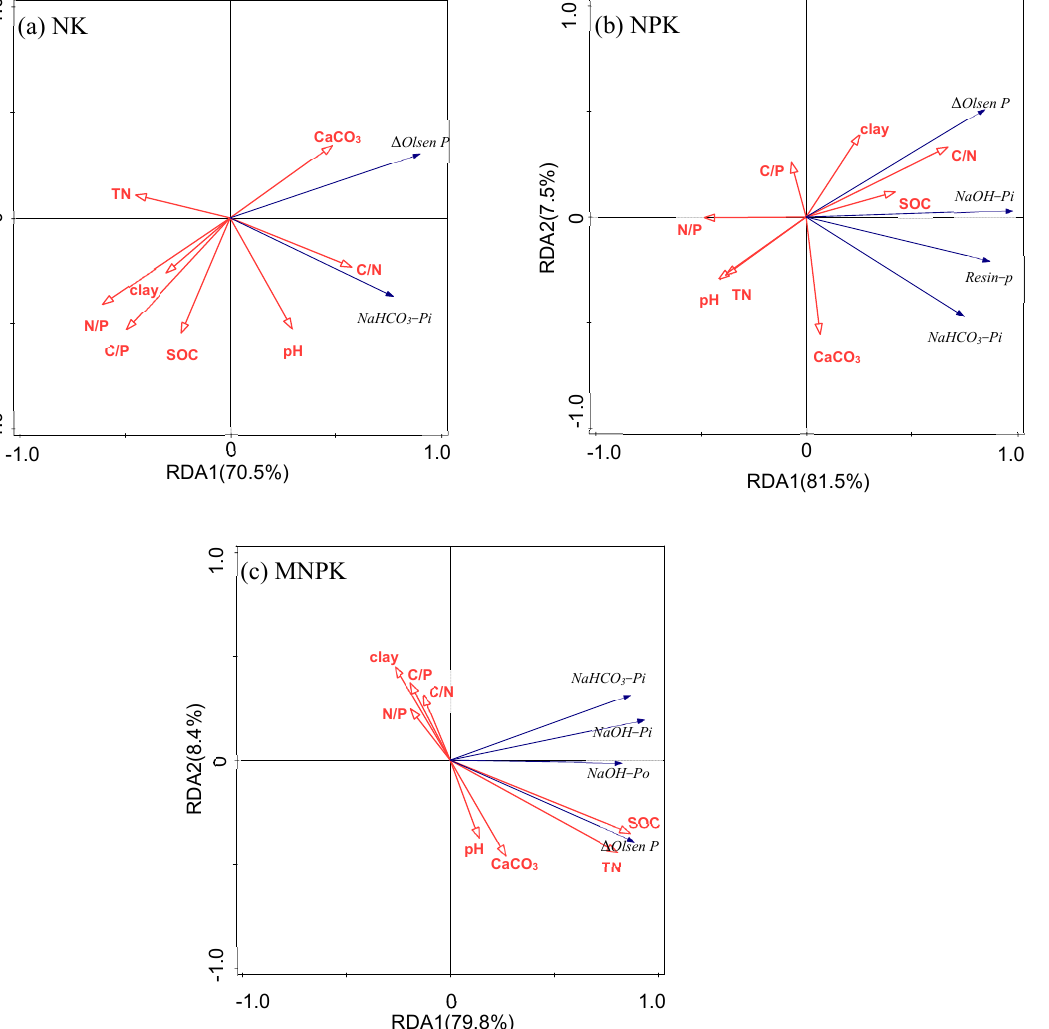
Figure 5. RDA analysis of P fractions and parameters. NK, nitrogen and potassium; NPK, nitrogen, phosphorus and potassium; MNPK, manure, nitrogen, phosphorus and potassium. ( a ) NK treatment, ( b ) NPK treatment, ( c ) MNPK